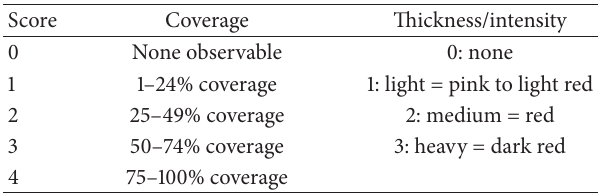
Table 2: Criteria for scoring plaque, where plaque is defined as “soft debris” and is visualized using ultraviolet illumination (modified Logan and Boyce as described by Hennet et al.